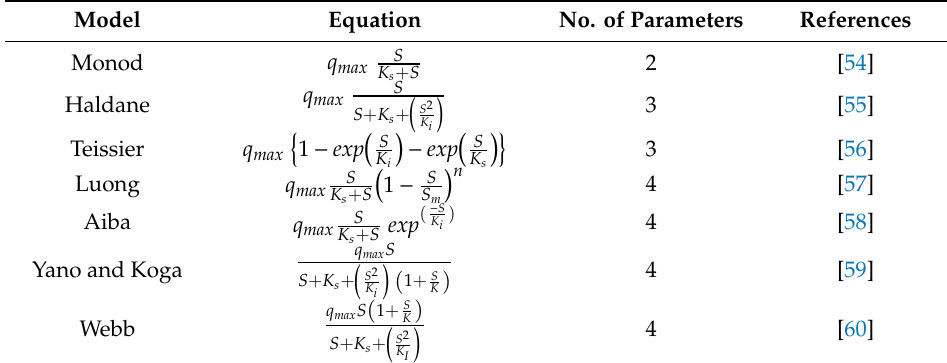
Table 2. Mathematical models developed for growth kinetics studies involving di ff erent substrate concentrations and conditions. Model